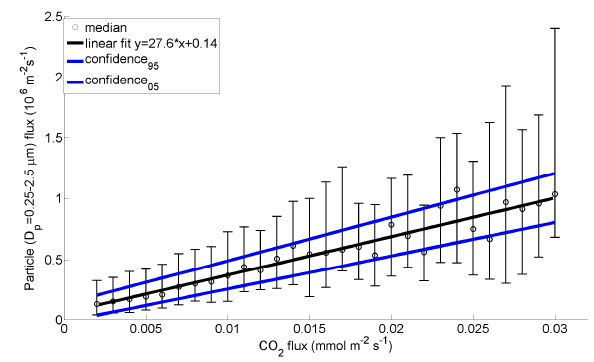
Fig 4. : Median values for particles particle flux with D p = 0.25-2.5 µm within constant intervals of CO 2 flux. The vertical bars represent 25 and 75 percentiles. The blue line represents the 95 confidence interval of the linear regression line.